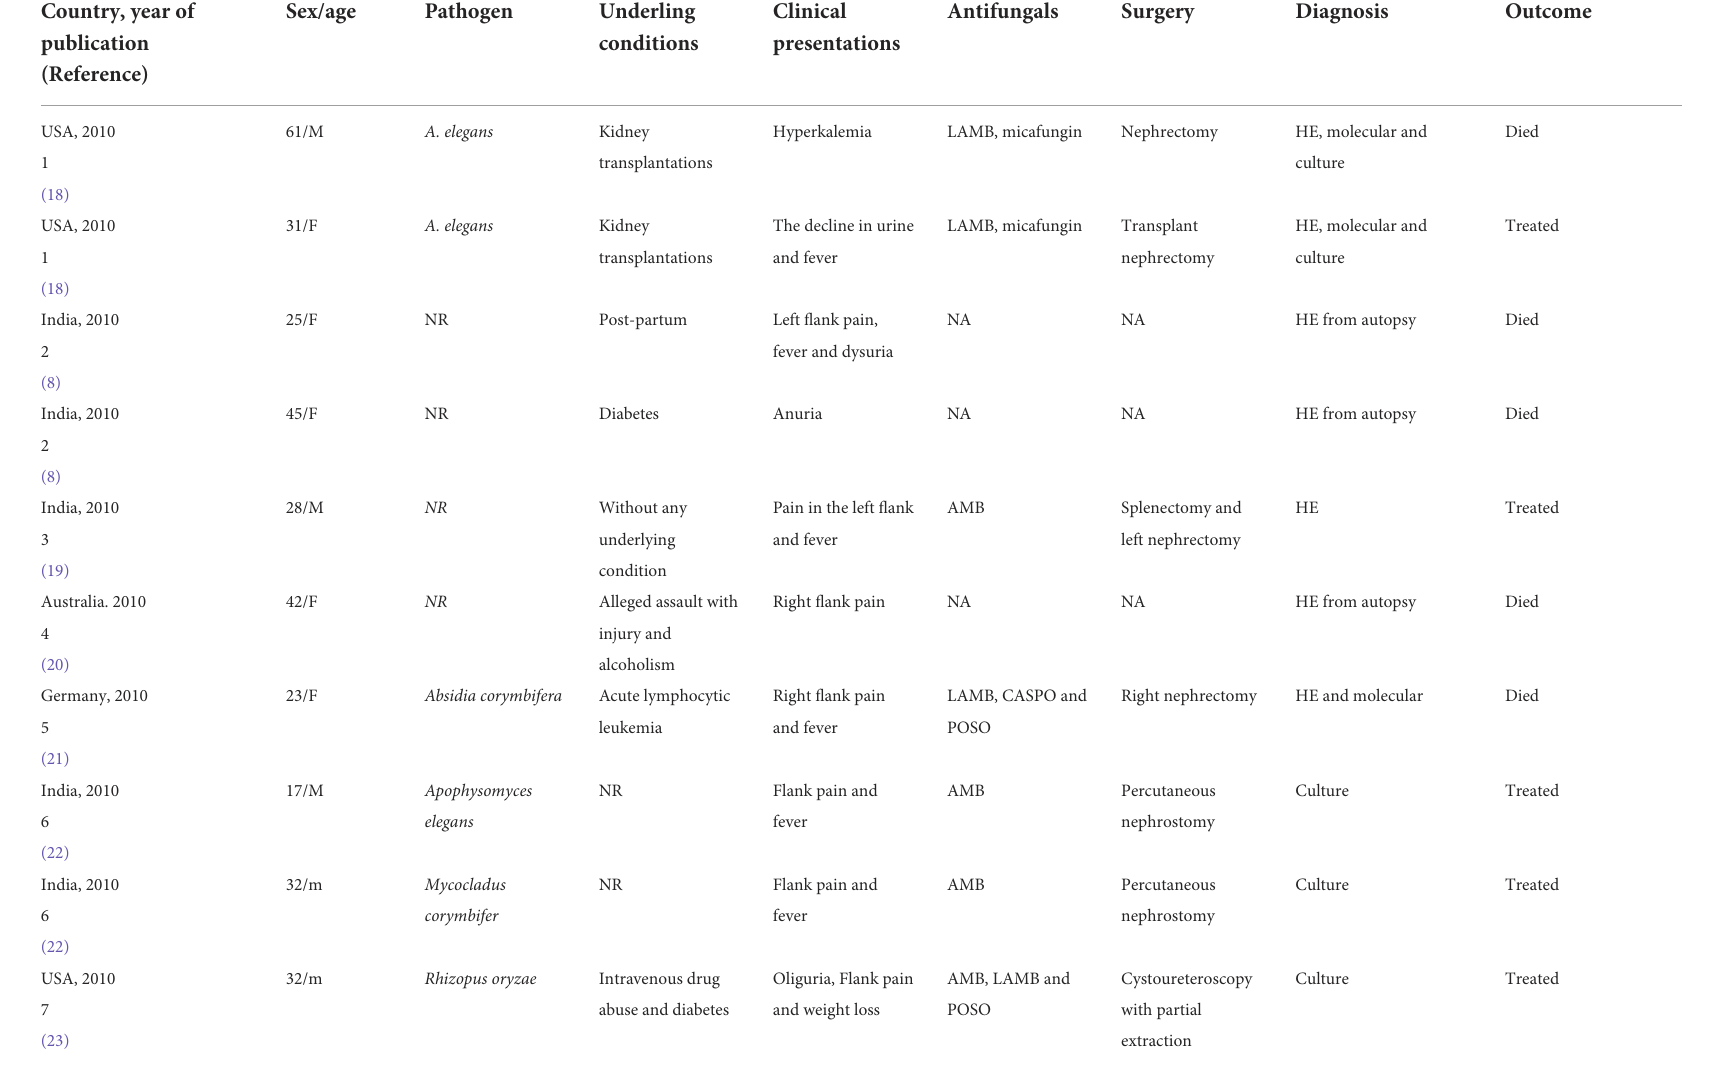
TABLE 1 Different clinical aspects of patients with renal mucormycosis (PubMed reported cases 2010 until April 2022). Country, year